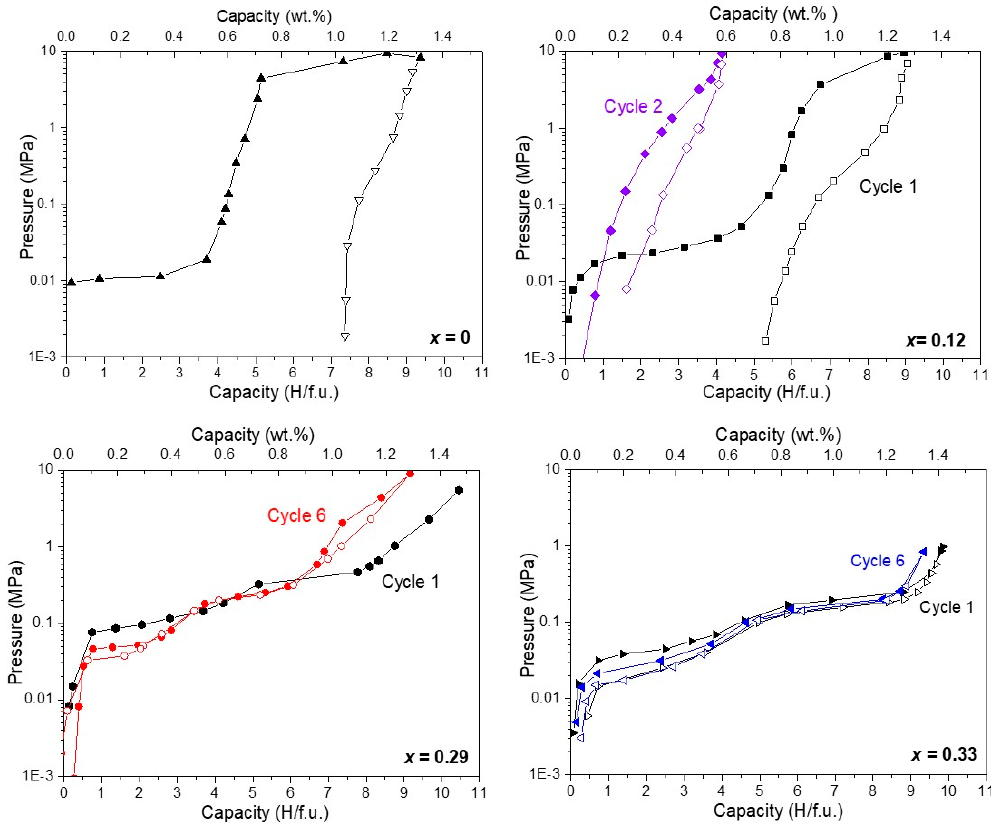
Figure 4. P-c isotherms of Sm 2 Mn x Ni 7 − x measured at 25 °C with x = 0, 0.12, 0.29 and 0.33, full symbols stand for absorption, open symbols stand for desorption. Table 2. First hydrogenation cycle properties at 25 °C of Sm 2 Mn x Ni 7 − x compounds with x = 0, 0.12, 0.29 * and 0.33.